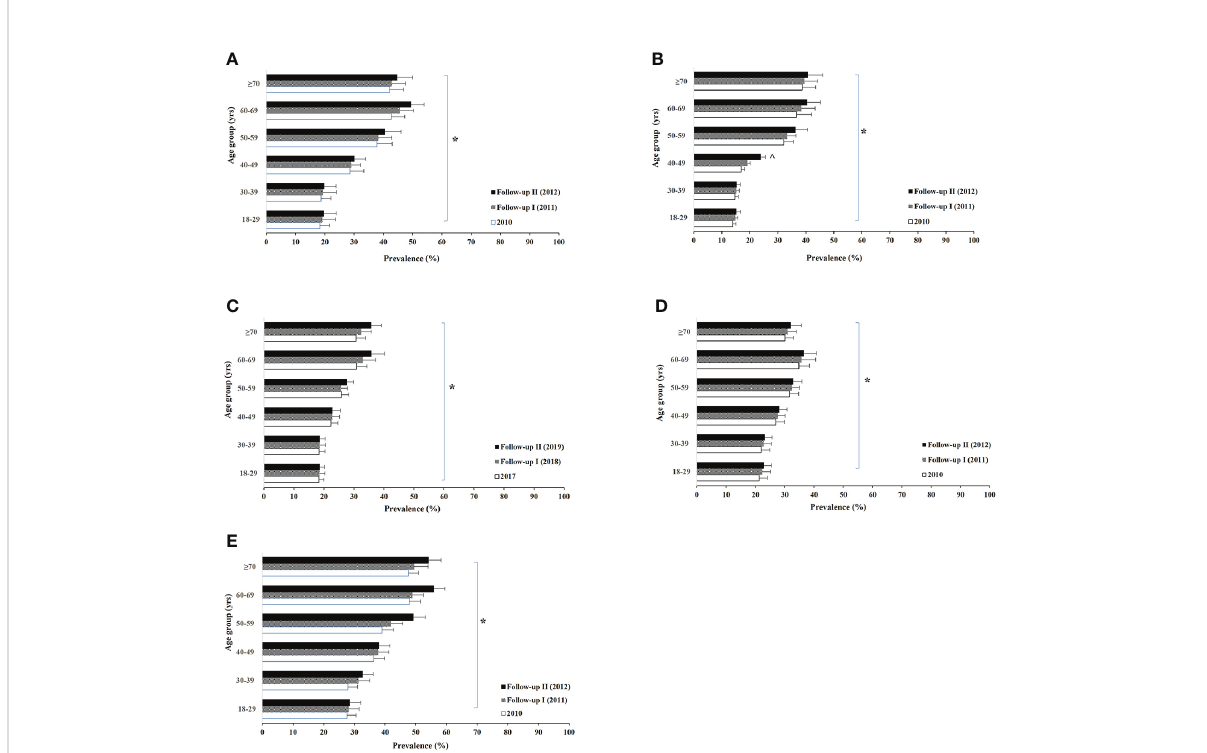
FIGURE 2 Female age-speci fi c prevalence of high total (non-HDL) cholesterol (A) , high low-density lipoprotein cholesterol (B) , low high-density lipoprotein (C) , high triglyceride (D) , and dyslipidemias (E) among urban adults in East Coast, Fujian, China between 2017 and 2019. Logistic regression analysis indicated: * aging trend within each lipid abnormality (A) p < 0.01; (B) p < 0.001; (C) p < 0.001; (D) p = 0.002; (E) p < 0.001, and ^ for time trend within the age group (B) p <